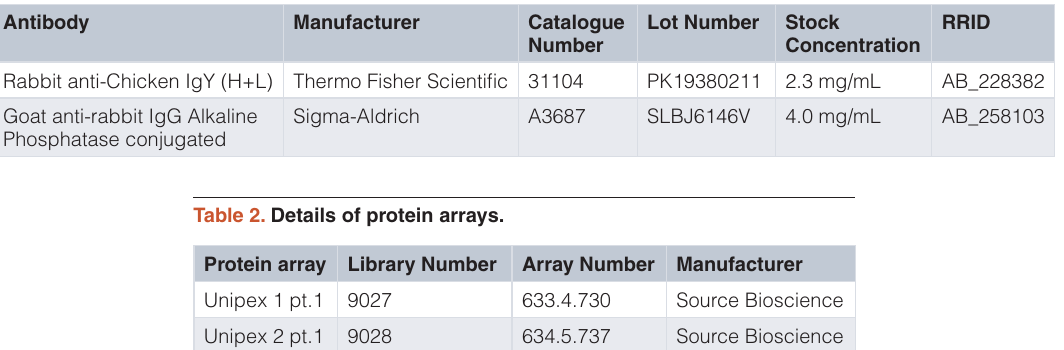
Table 1. Details of characterised antibodies.